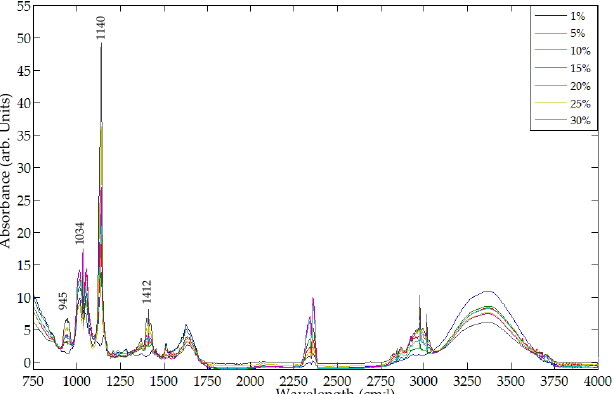
Figure 8. Representative FT-IR spectra of mixture samples at all concentration levels.